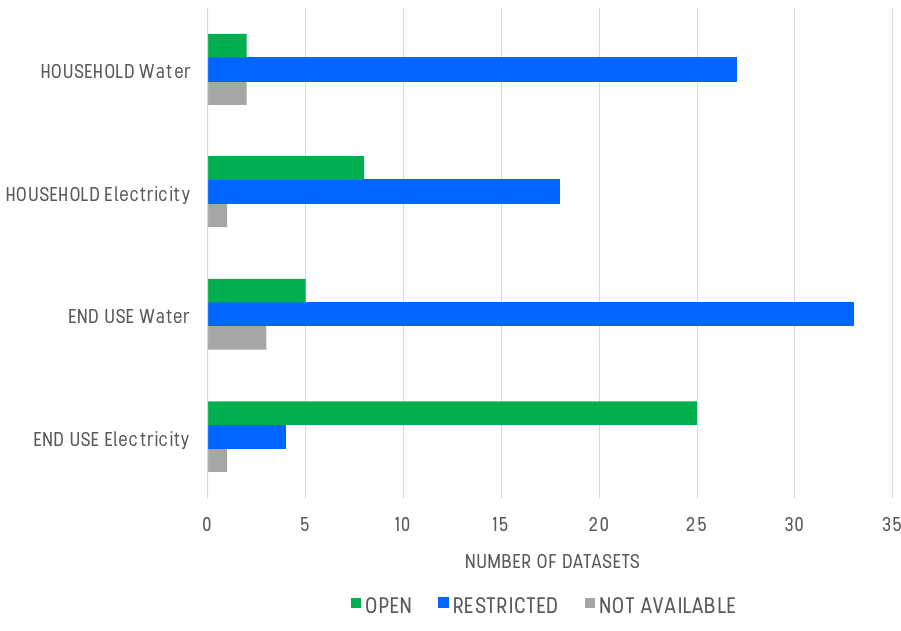
Figure 9. Comparison between water and electricity dataset accessibility at the household and end use